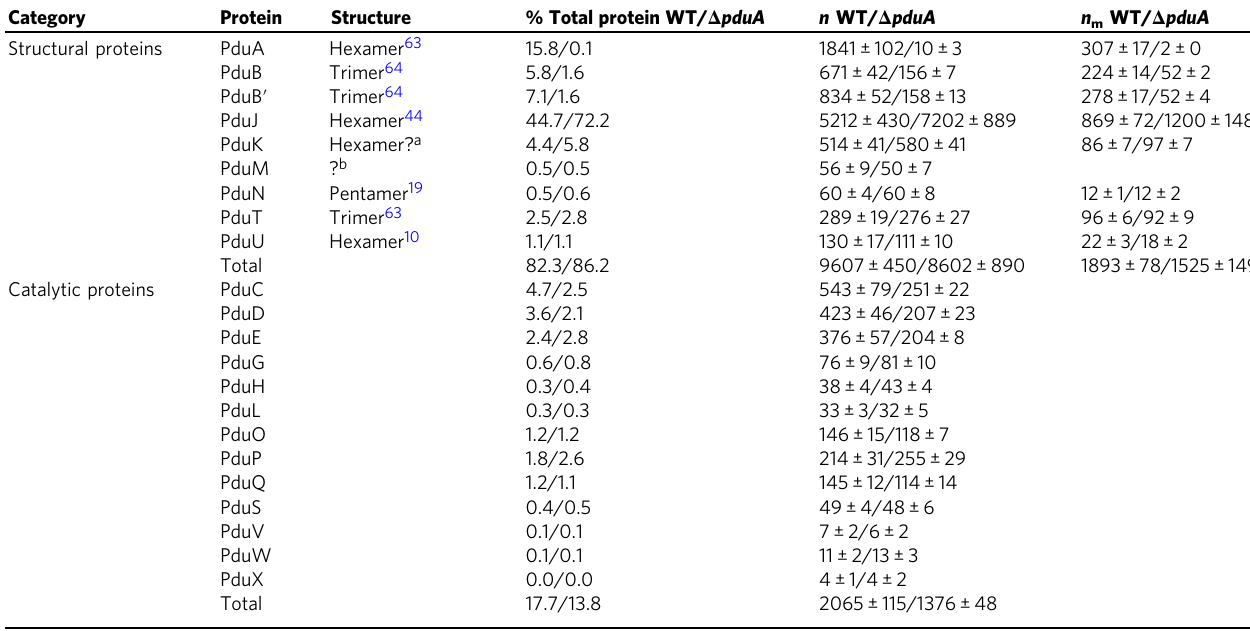
Table 1 Absolute quanti fi cation of Pdu proteins in S . Typhimurium LT2-WT and LT2- Δ pduA . Category Protein Structural proteins